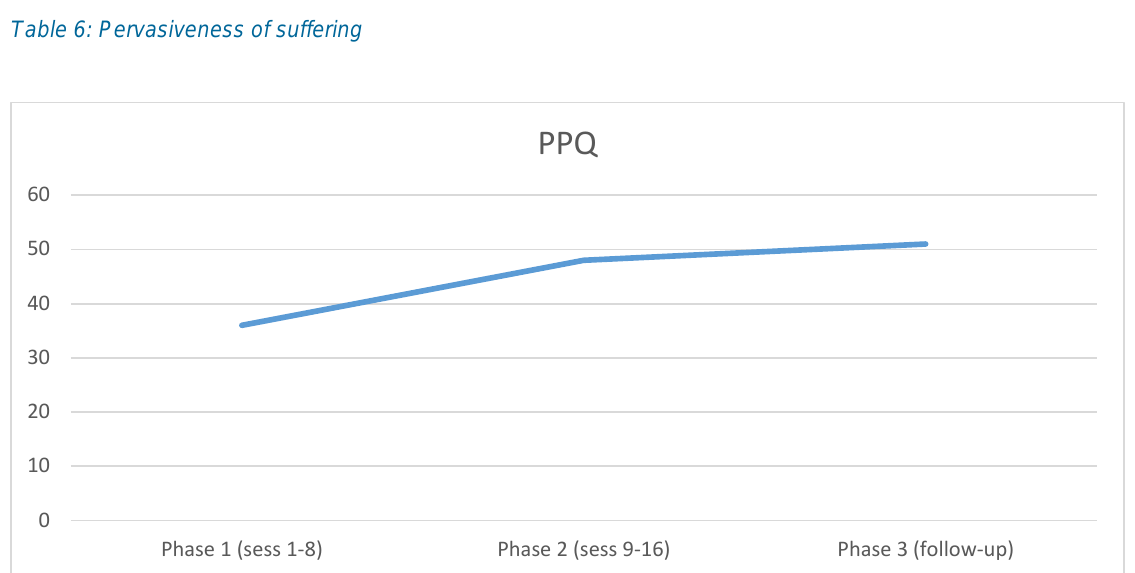
Figure 3: Severity of client’s perceived suffering across the three phases of the therapy